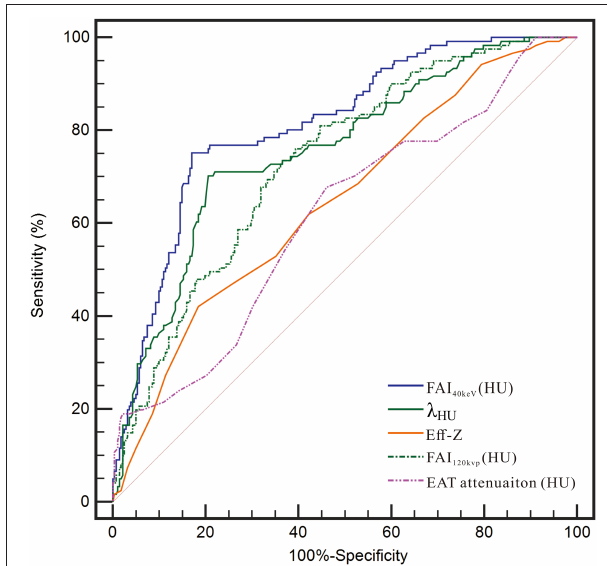
FIGURE 5 | Receiver operating characteristic (ROC) curve analysis showed that compared with other parameters, the FAI 40kev had the highest the area under curve